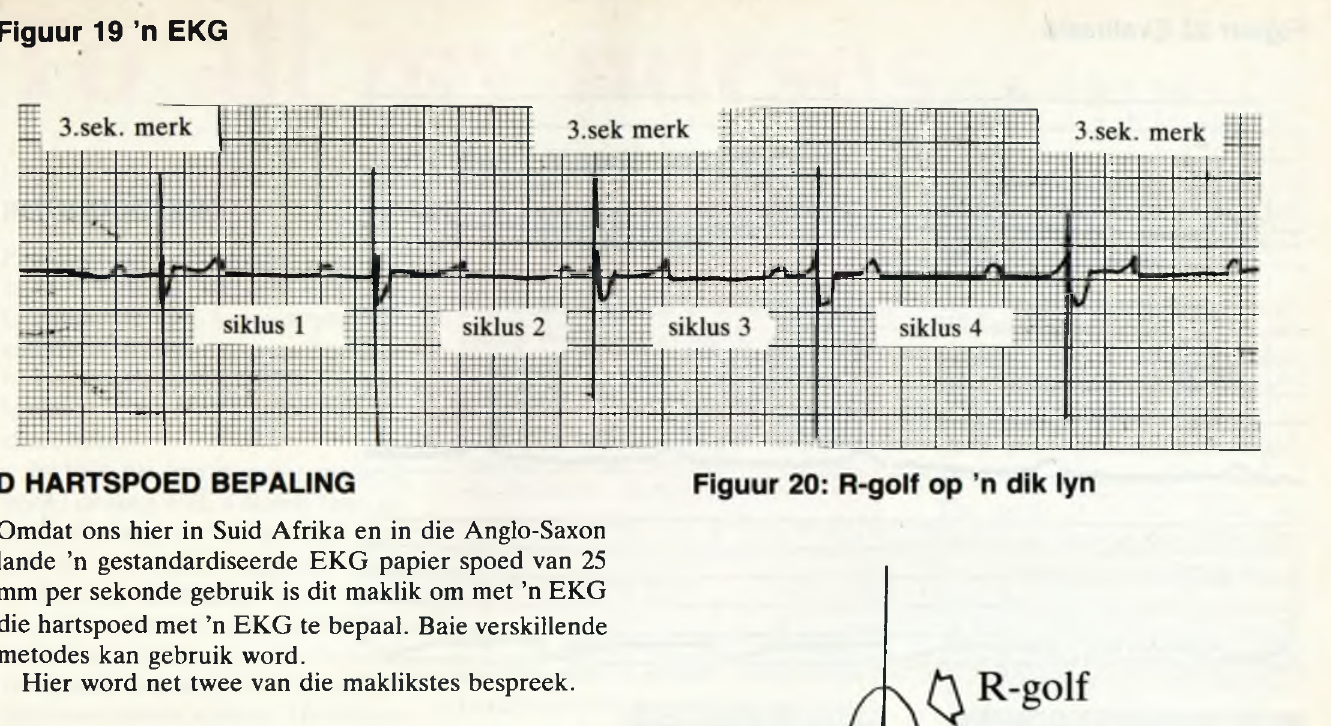
Figuur 21: Telling om polsspoed te bepaal “300, 150,100” “75, 60,